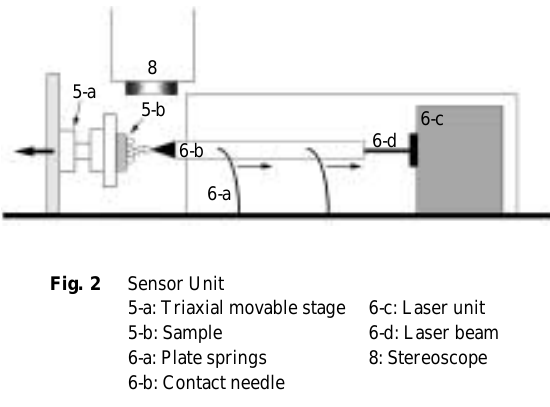
Fig. 2 Sensor Unit 5-a: Triaxial movable stage 6-c: Laser unit 5-b: Sample 6-d: Laser beam 6-a: Plate springs 8: Stereoscope 6-b: Contact